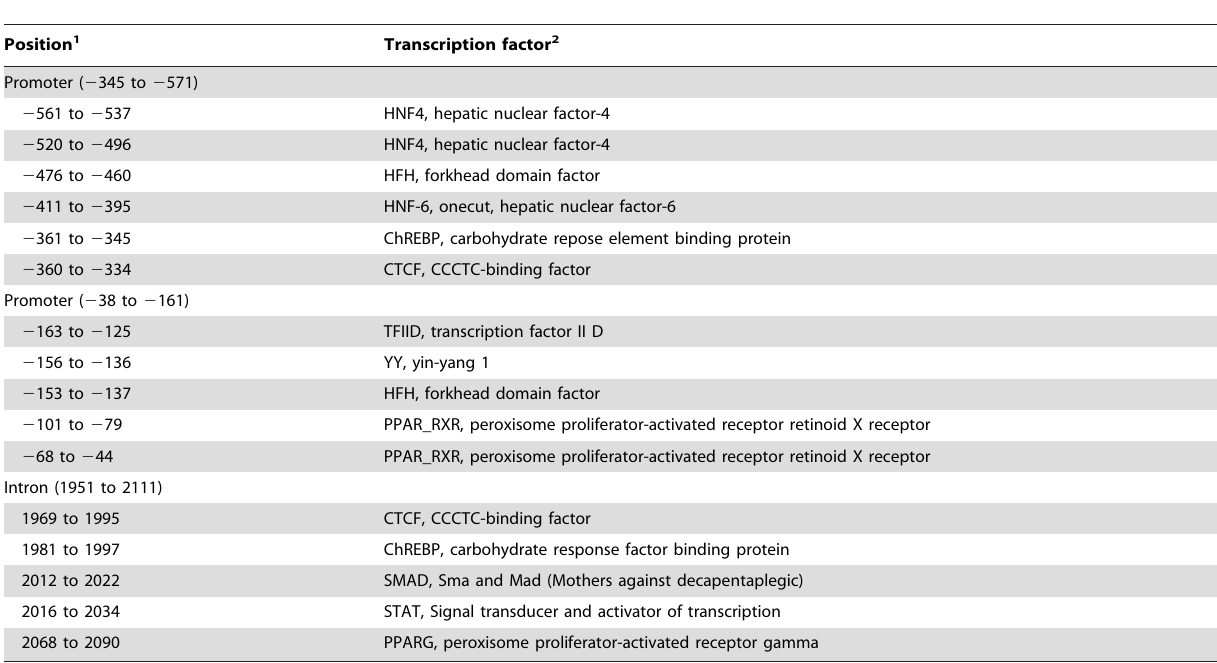
Table 3. Potential transcription factor binding sites near the human glucokinase liver-specific 1 st